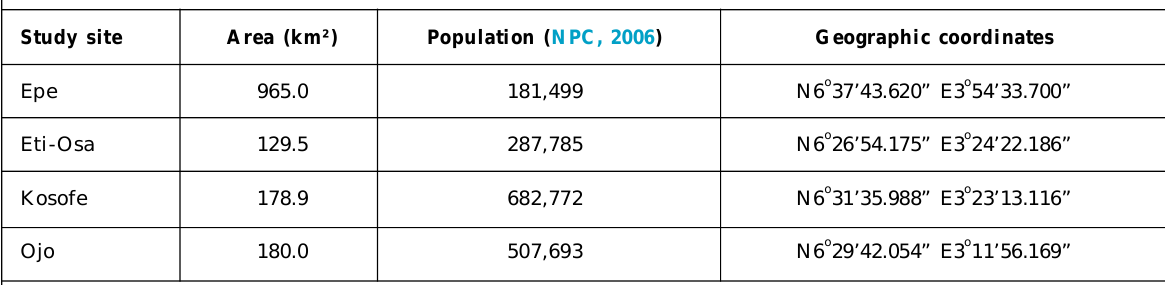
Table 1: Selected Culex quinquefasciatus breeding habitats and their geographical coordinate Study